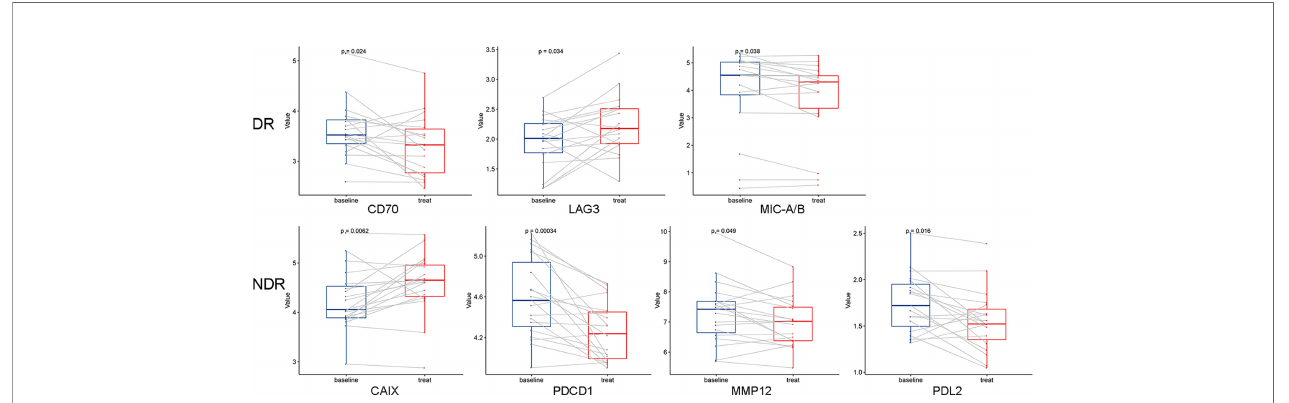
FIGURE 3 | Dynamic changes of 7 proteins used in the linear discriminant analysis prediction model. A paired two-sided t test was used, a=0.05. DR, durable responders; NDR,